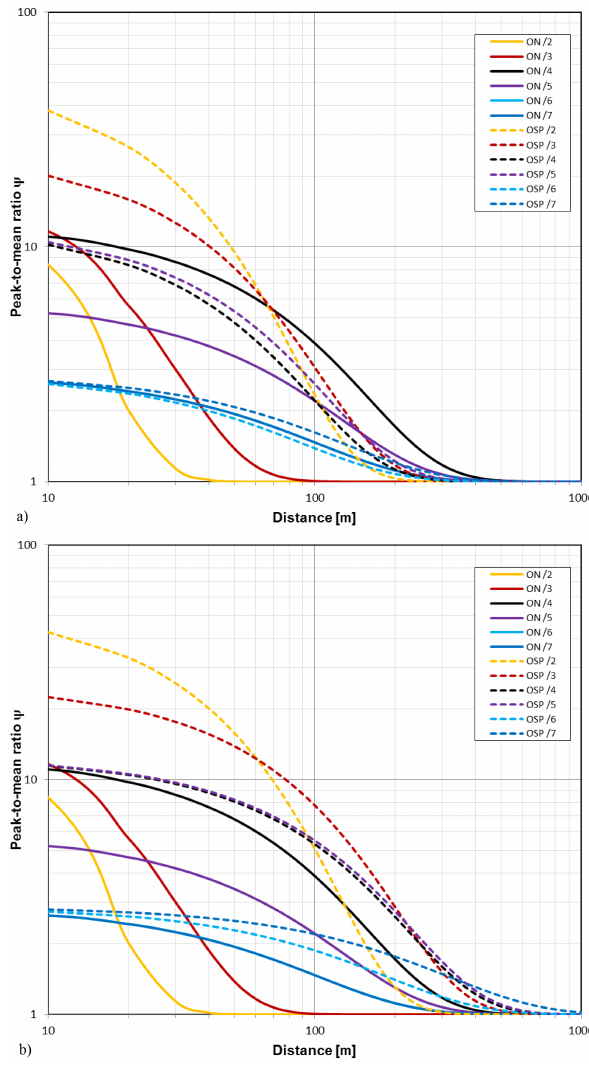
Figure 1. Peak-to-mean ratio attenuation curves dependent on at- mospheric stability (classes 2 to 7) for (a) Linz and (b) Kittsee. The solid lines (ON) indicate the curves derived from Robins (1979) and the dashed lines (OSP) indicate those determined using the Obukhov stability parameter from the three-dimensional ultrasonic anemometer.